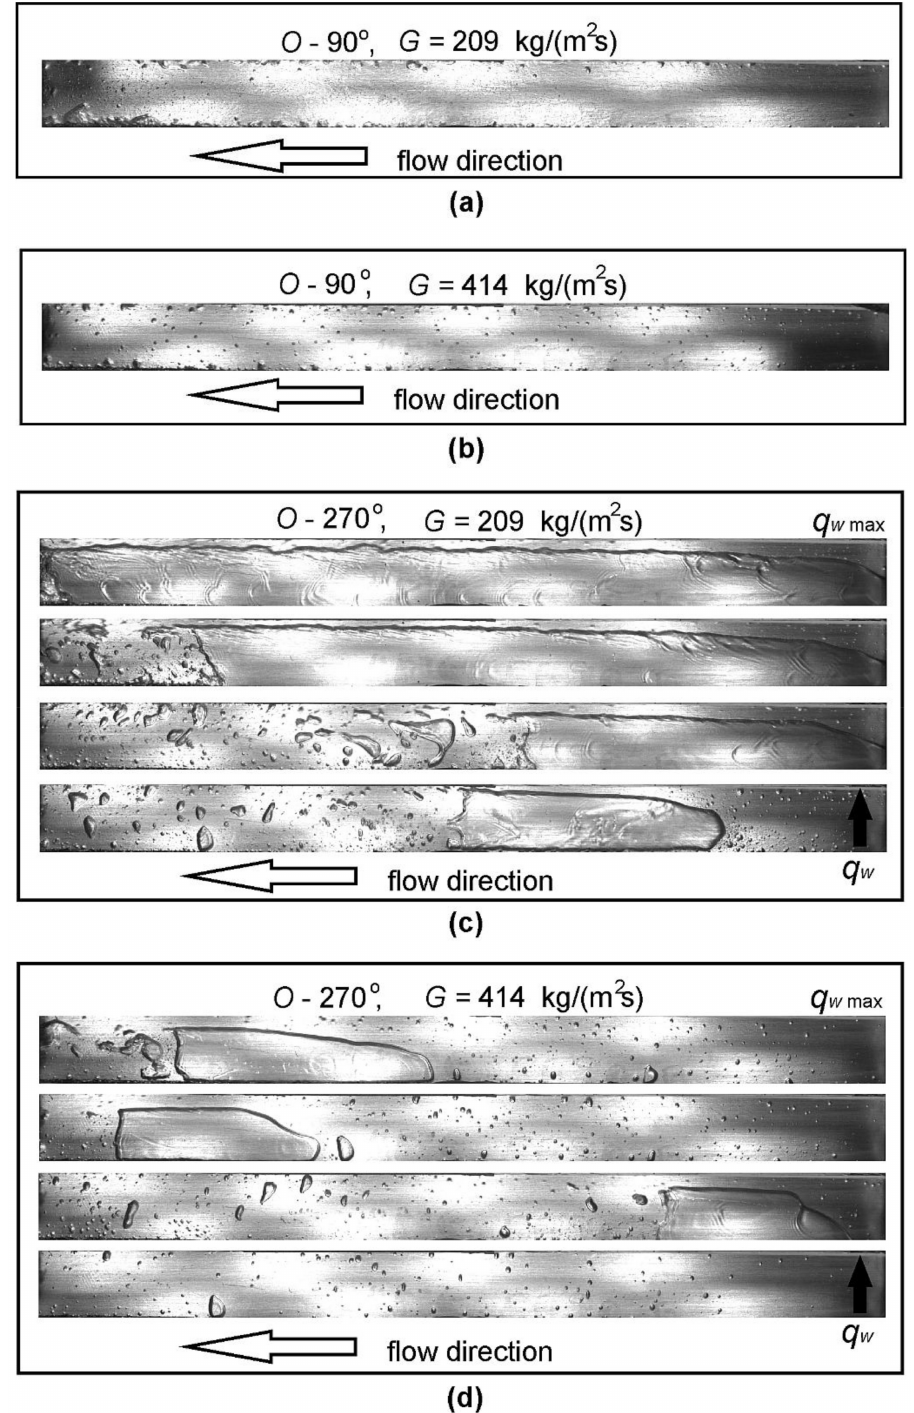
Figure 12. Images of two-phase flow structures recorded for: various mass fluxes and two vertical channel orientations (90 ◦ and 270 ◦ ), HFE-649, smooth heated plate, L IRT = 180